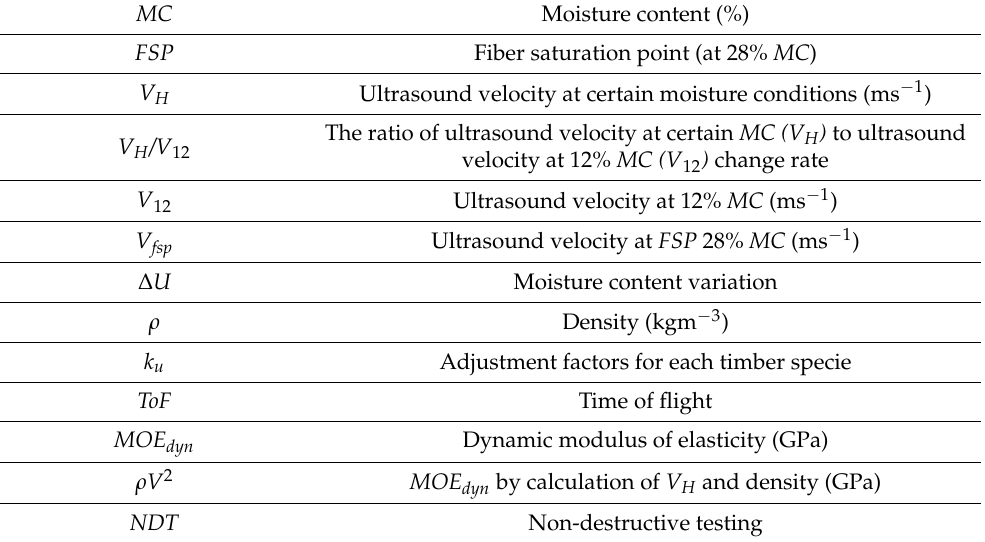
Table 1. Symbols in the present